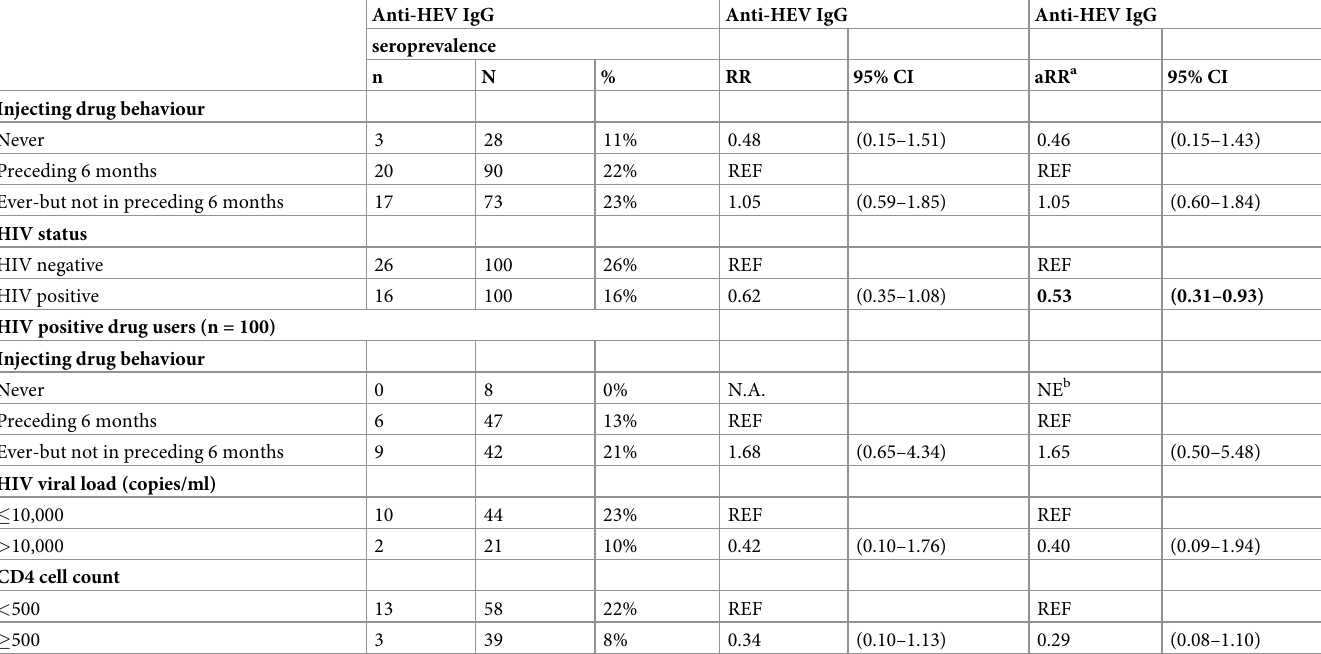
Table 5. Anti-HEV immunoglobulin G seroprevalence among persons who use drugs (n =